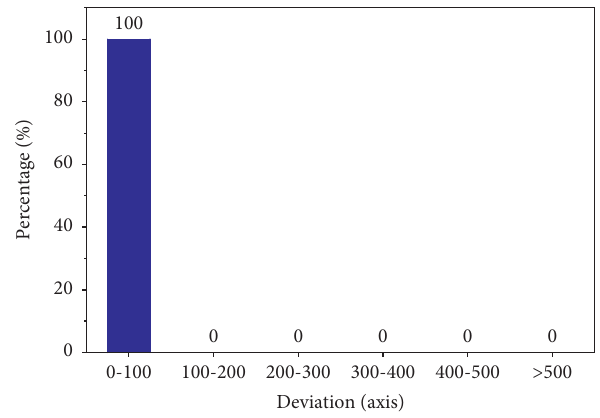
Figure 14: MAE histogram of straight trajectory